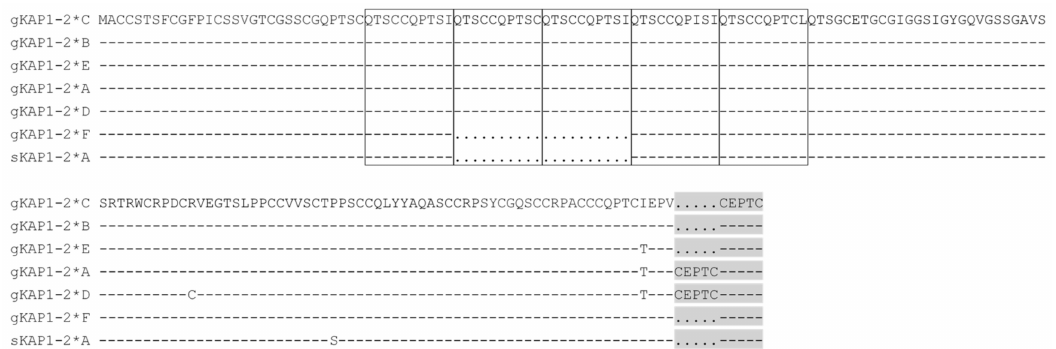
Figure 4. Alignment of the predicted amino acid sequences derived from the caprine KAP1-2 gene sequences and ovine KAP1-2 variant A . The prefix “g” and “s” stand for goat and sheep sequences, respectively. The dashes indicate identity with caprine KAP1-2*C and the dots represent amino acid deletions. The decapeptide ‘QTSCCQPT(S/C)X’ repeats are boxed, and pentapeptide ‘CEPTC’ repeats are shaded. The levels of cysteine (21.7–23.1%) and serine (15.3–15.8%) were high, while the content of threonine (9.6–11.5%), proline (9.6–9.9%), glutamine (8.3–9.6%) and glycine (8.2–9.6%) was moderate in the predicted polypeptide sequences encoded by caprine KRTAP1-2